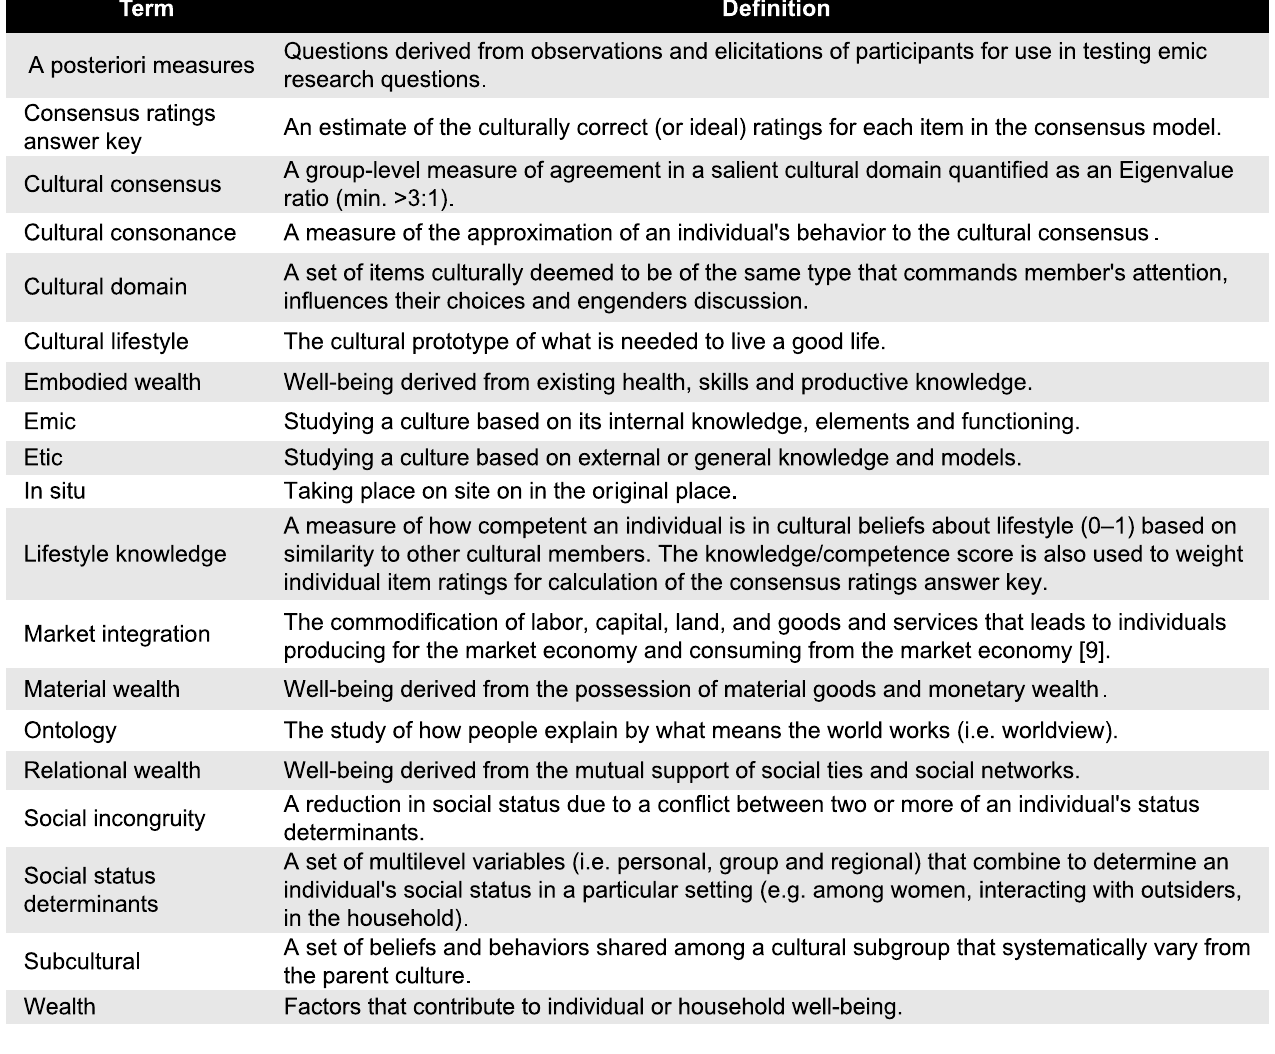
Fig 1. Glossary of key